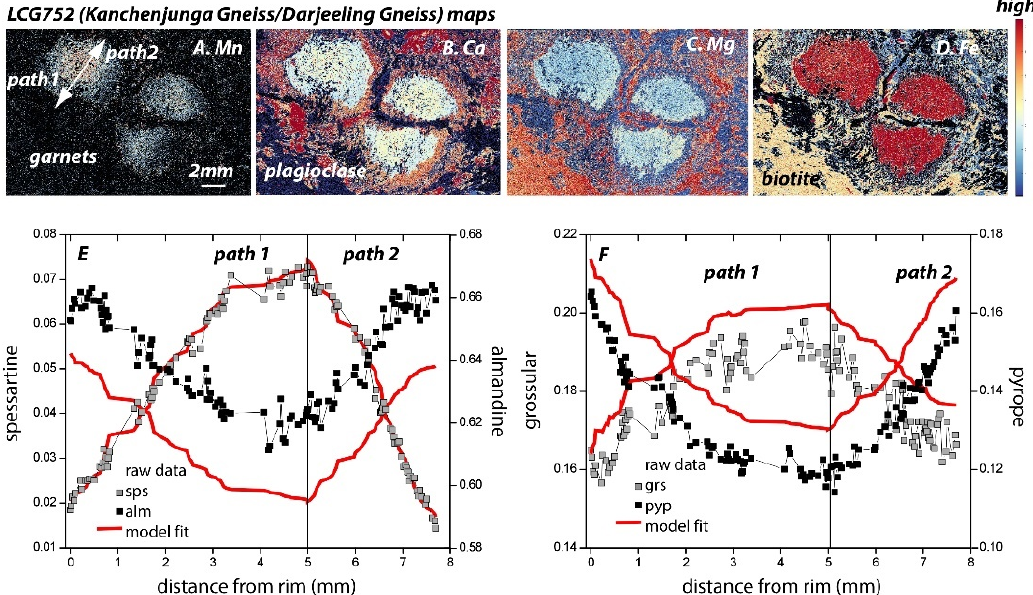
Figure 13. X-ray element maps of sample LCG752 (Kanchenjunga/Darjeeling Gneiss) in ( A ) Mn, ( B ) Ca, ( C ) Mg, and ( D ) Fe. Garnet compositions in spessartine (sps) and almandine (alm) (panel E ) and grossular (grs) and pyrope (pyp) (panel F ) were taken across the rim to rim transects identified in panel ( A ). The red lines in panels ( E , F ) show the prediction of the high-resolution P-T paths generated for this sample.